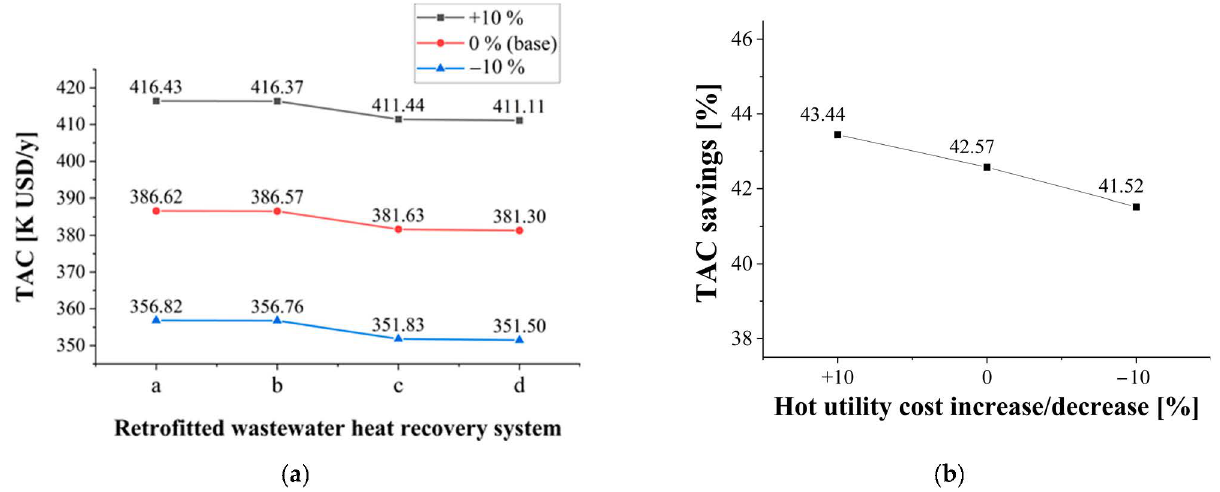
Figure 8. Sensitivity analysis of C u system as C u changes, ( b ) maximum TAC savings as C u h